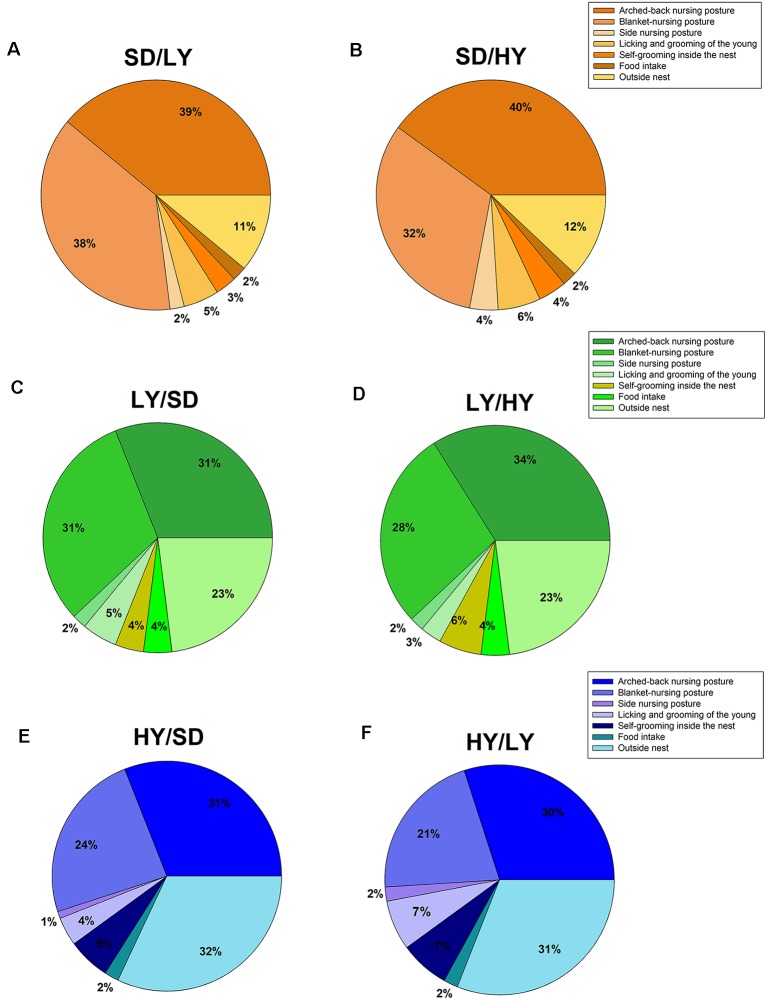
Maternal care in cross-fostered male rats raised by HY or LY sublines or by SD dams. (A) SD dams that raised LY male rats (SD/LY) did not differ in their maternal behavior components. (B) SD dams showed an increase time spend outside the nest, but the difference was not significant (SD/HY). (C,D) LY dams showed a decreased frequency of the arched-back nursing posture compared to SD dams (SD/LY) or with respect to LY dams that raised HY male rats (LY/HY). (E,F) HY dams showed a lower proportion of blanket-nursing posture with respect to SD (HY/SD) or LY rats (HY/LY).